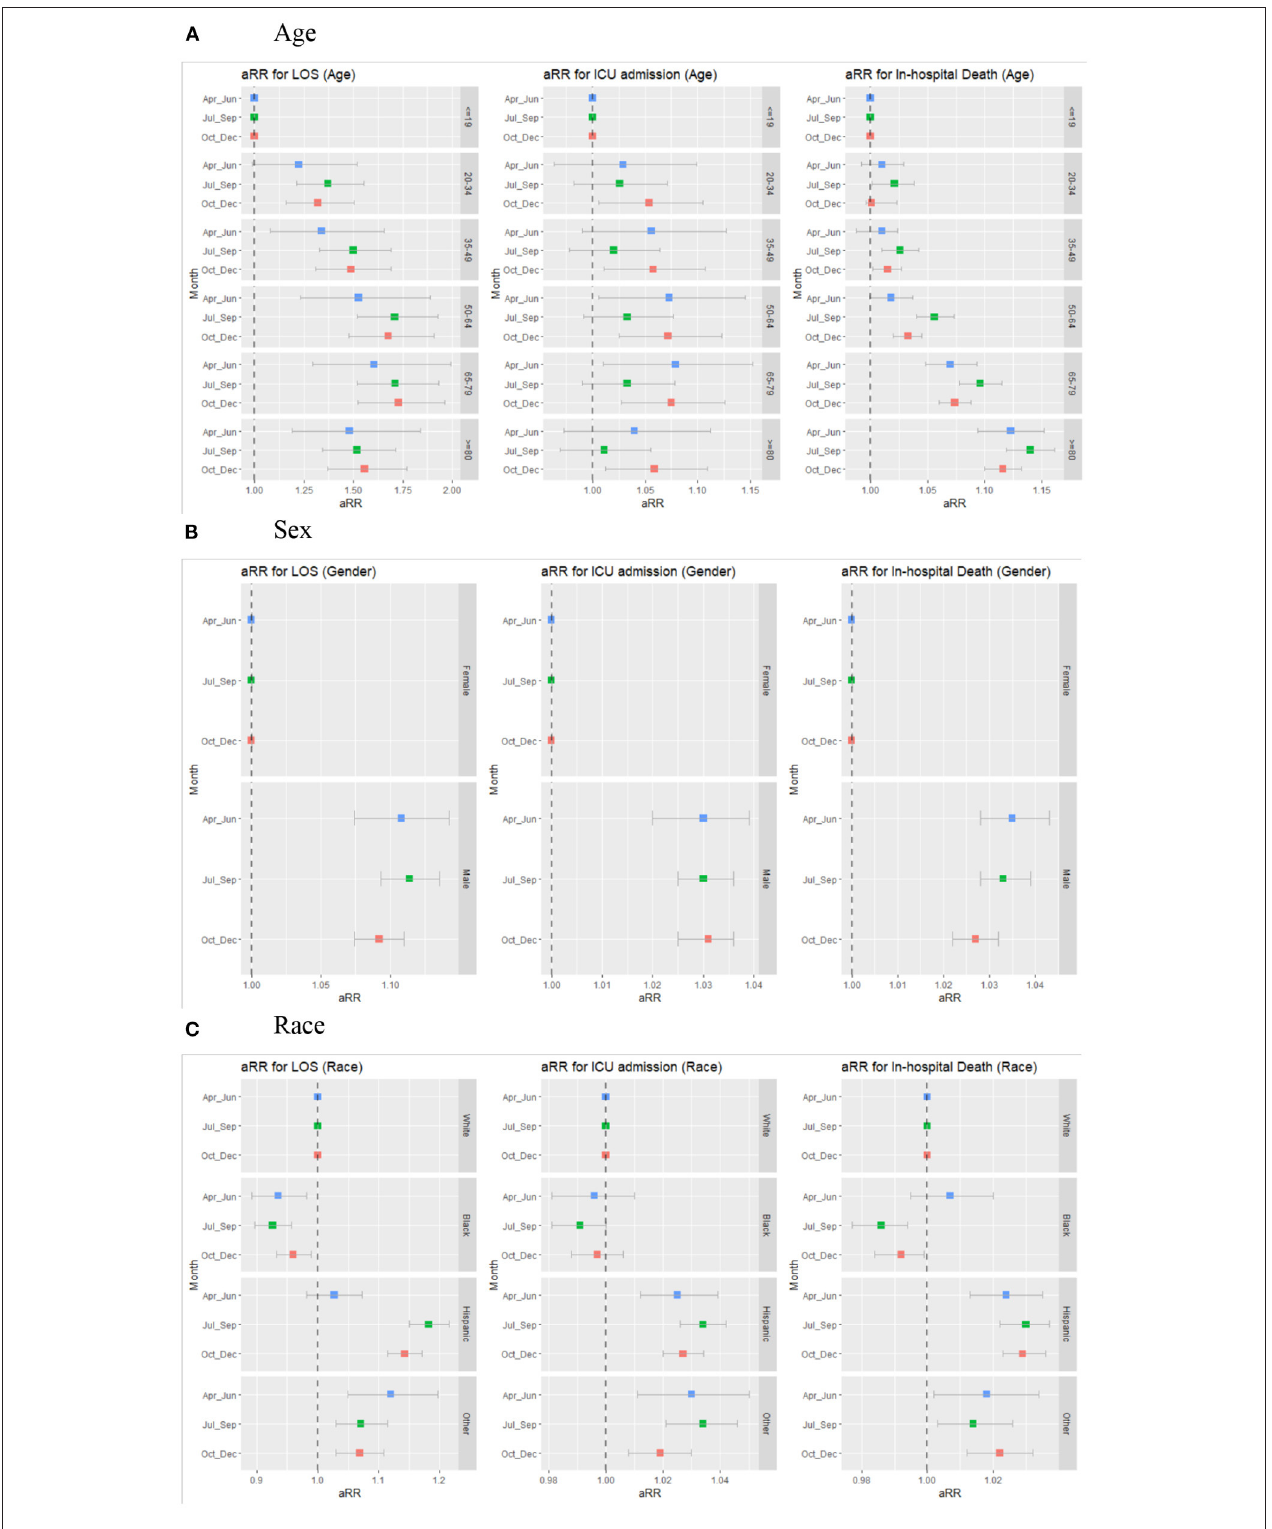
FIGURE 2 | Trends in adjusted risk ratios for LOS, ICU admission, and In-hospital death by age, sex, race/ethnicity over the last three quarters of 2020. (A) Age. (B) Sex. (C) Race. The estimates are from multivariable regression analysis stratified by each quarter, adjusting for covariates in Model 1 and comorbidity of patients.